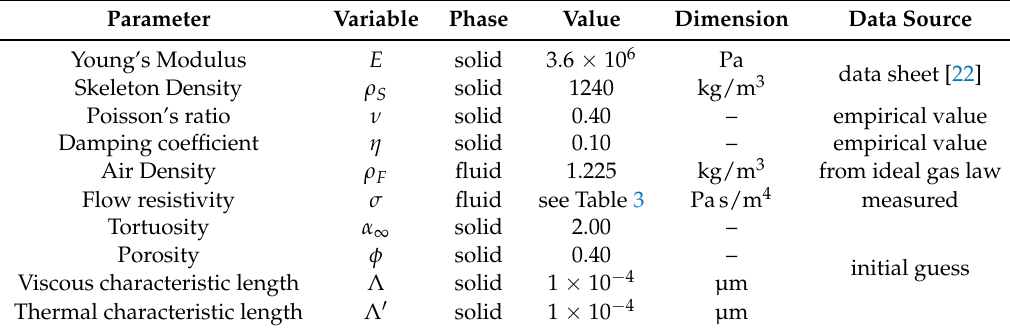
Table 2. Material parameters for B IOT -model and data sources before optimization.